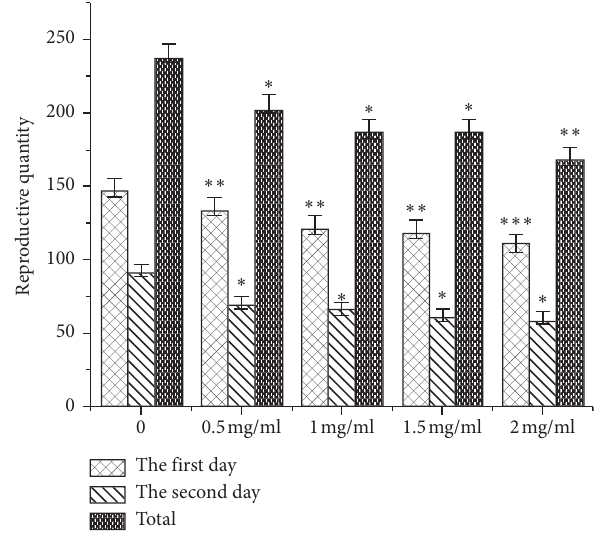
Figure 5: Effects of essential oils on the reproduction rate in C. elegans . Results include at least three independent biological replicates. Error bars represent the standard error, and differences compared to the control (for each column of 0 mg/ml, 0.1% DMSO) were considered significant at ∗ p < 0 . 05, ∗∗ p < 0 . 01, and ∗∗∗ p < 0 . 001 by one-way ANOVA and the LSD post hoc test.